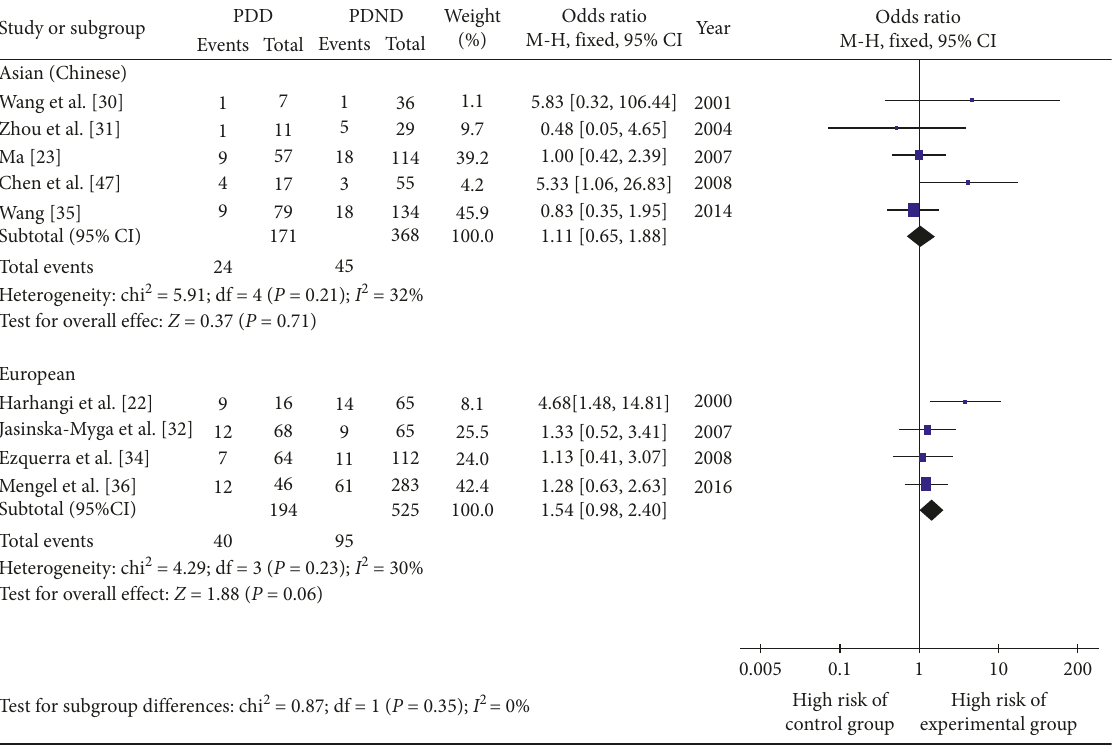
Figure 6: Forest plot for the influence of regional distribution on Parkinson’s disease dementia onset risk of ε 2+